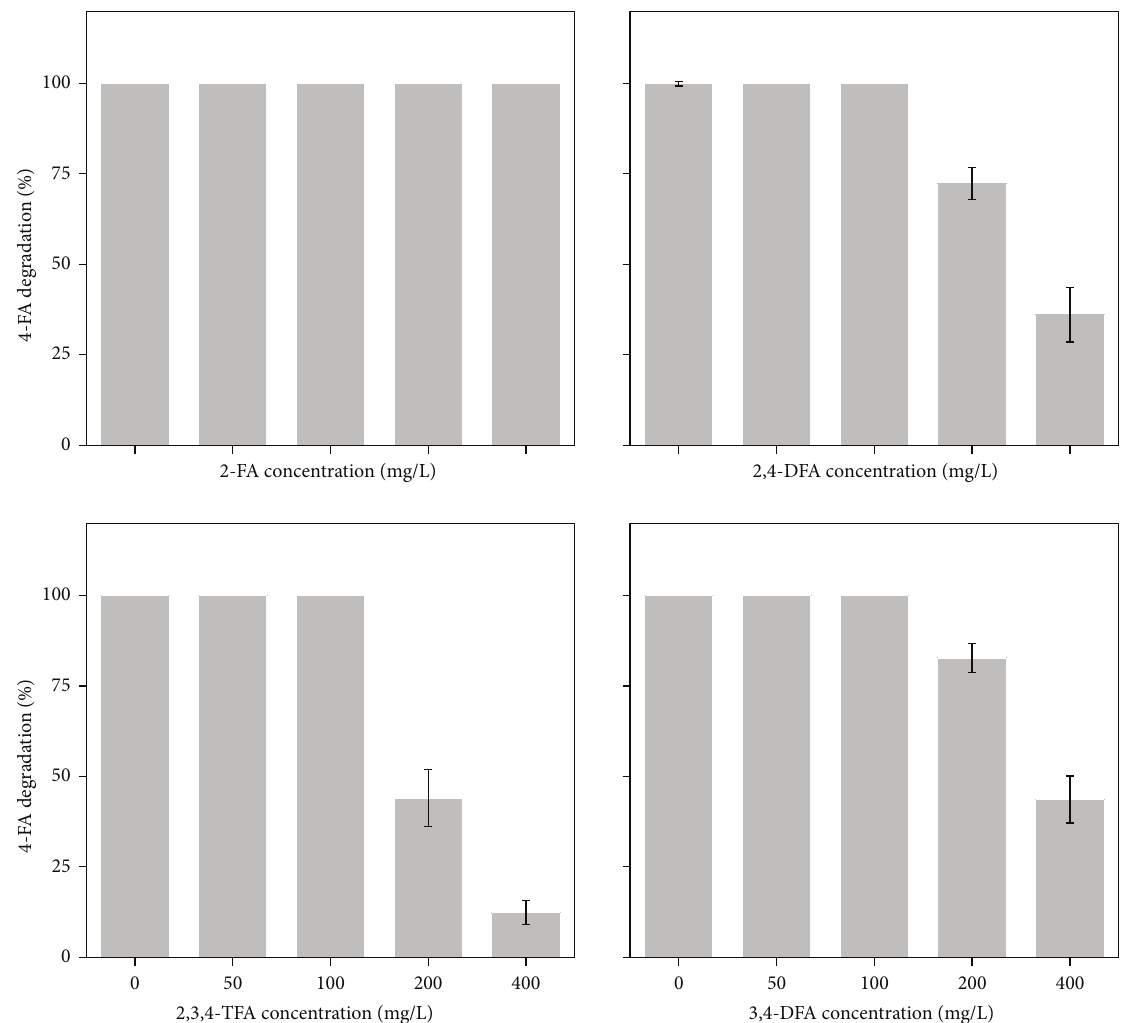
Figure 4: 4-FA degradation by strain FD-1 in cometabolism systems at 24 h.